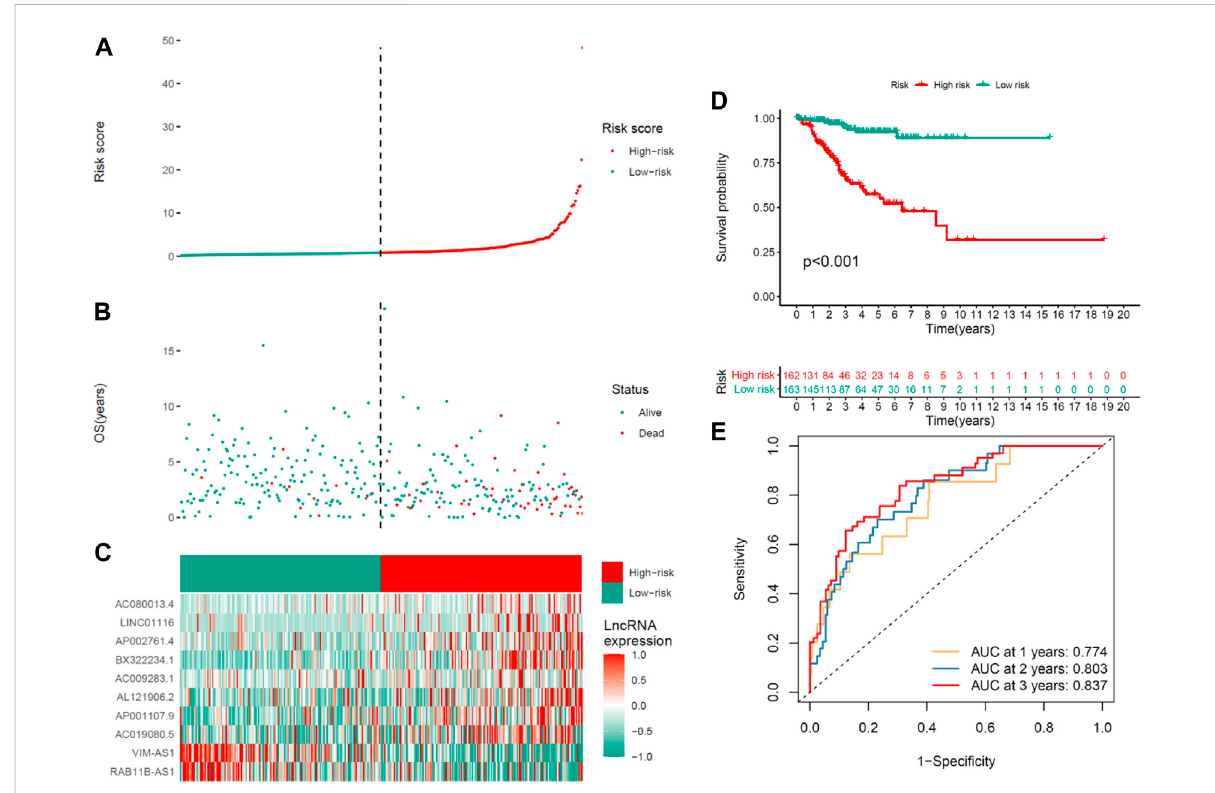
FIGURE 2 Prognosisabilityoftheriskmodelofthe10COVID-19 – associatedlncRNAsinthetrainingset. (A) Distribution ofCOVID-19 – associatedlncRNA model – based risk score. (B) Situations of the survival period and survival state between high- and low-risk groups. (C) Clustering analysis heatmap shows the expression levels of the 10 prognostic lncRNAs for the respective patient. (D) Kaplan – Meier survival curves of OS of patients in the high- and low-risk groups. (E) 1-, 2-, and 3-year ROC curves for OS prediction in accordance with COVID-19 – associated